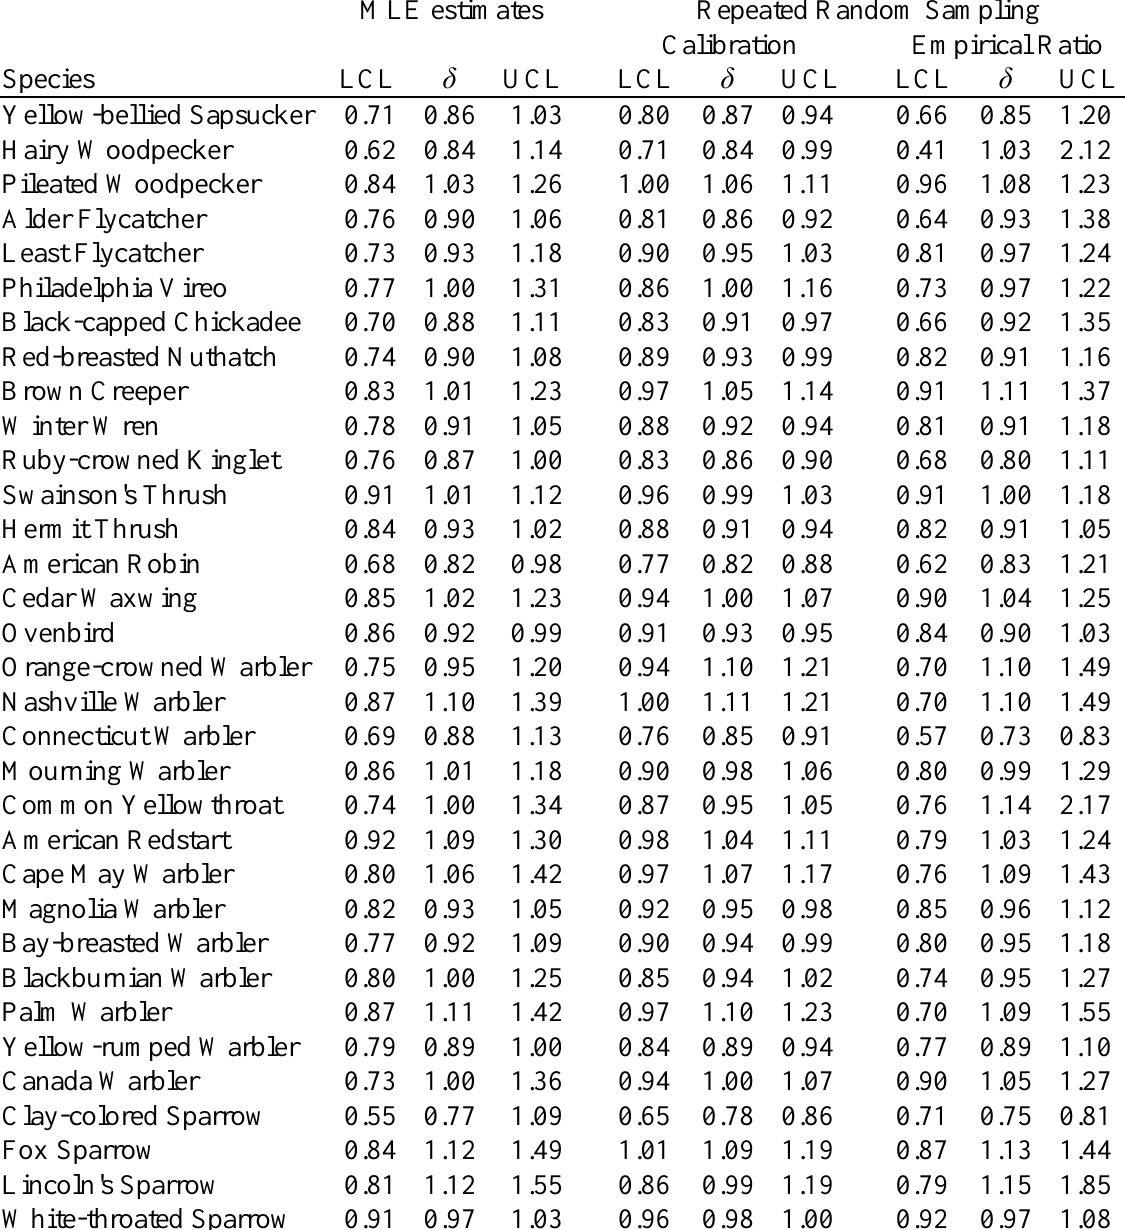
Table A1.2 Estimated scaling constants ( δ and both lower (LCL) and upper (UCL) 95% confidence intervals) relating counts from autonomous recording units (ARUs) to those by human observers for 35 species and calculated as √exp⁡(𝛽) from generalized linear mixed effects regression models (see Methods). Presented are maximum likelihood (MLE) estimates of δ and 95% CIs estimated as the median and the 2.5 and 97.5% quantiles from 10,000 Monte Carlo simulations drawn from a multivariate normal distribution treating the model coefficients (including the survey effect β ) as the mean and the estimated variance-covariance matrix. Also presented are calibration δ and empirical ratios (dividing the mean ARU count by the mean human observer count) derived from 50 repeated random (70% versus 30%) sub-samples of the data (see